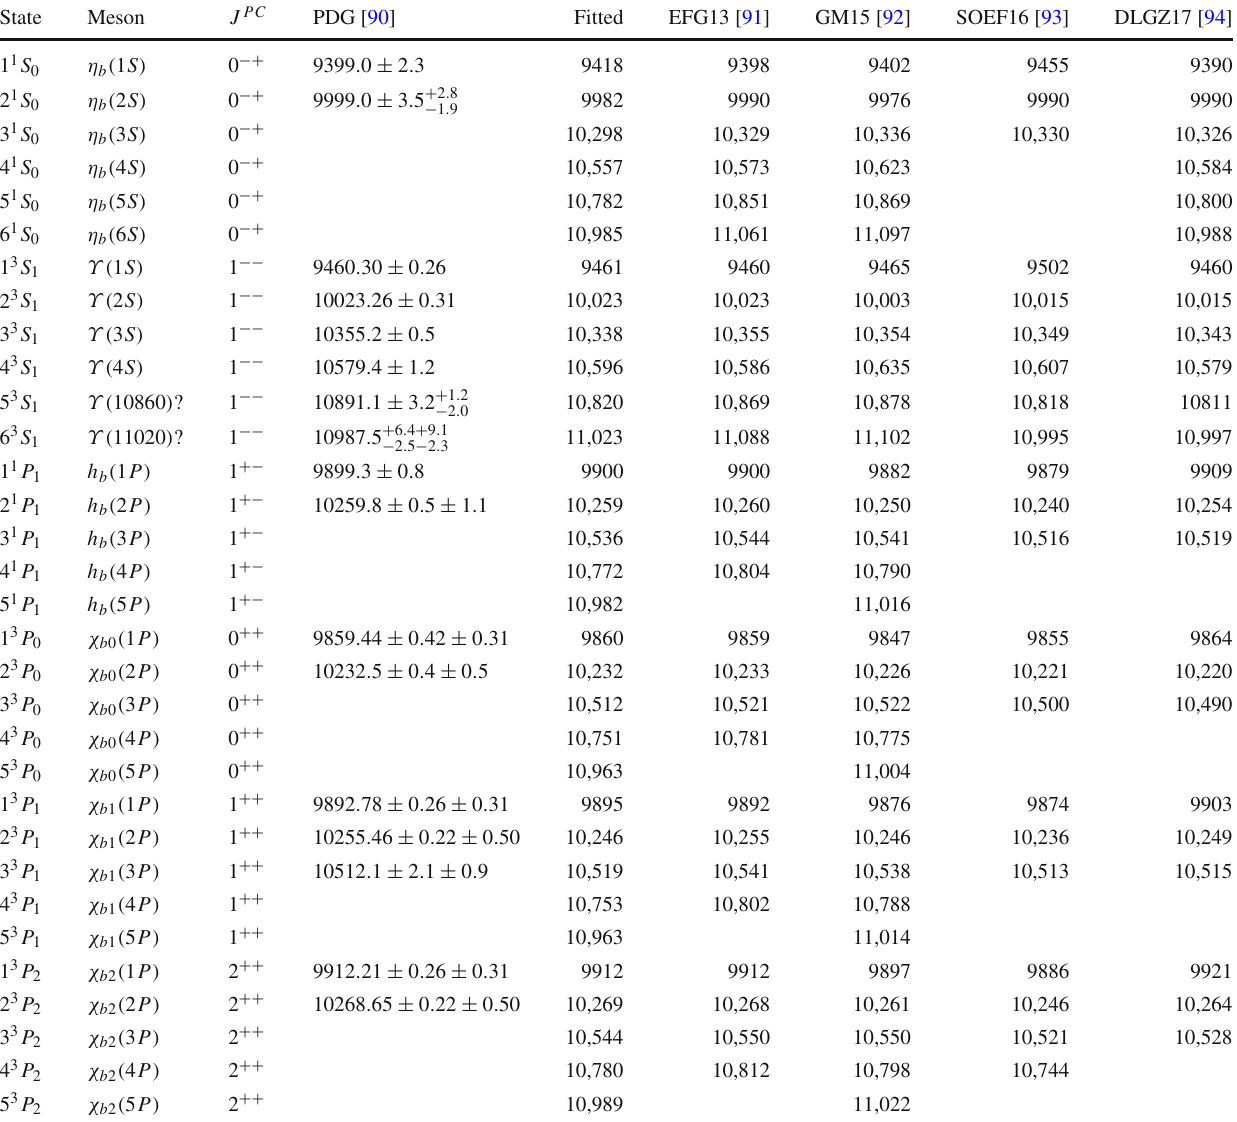
shown in comparison with the theoretical values of EFG13 [91], GM15 [92], SOEF16 [93] and DLGZ17 [94]. ? denotes the possible candidates for the unwell-established